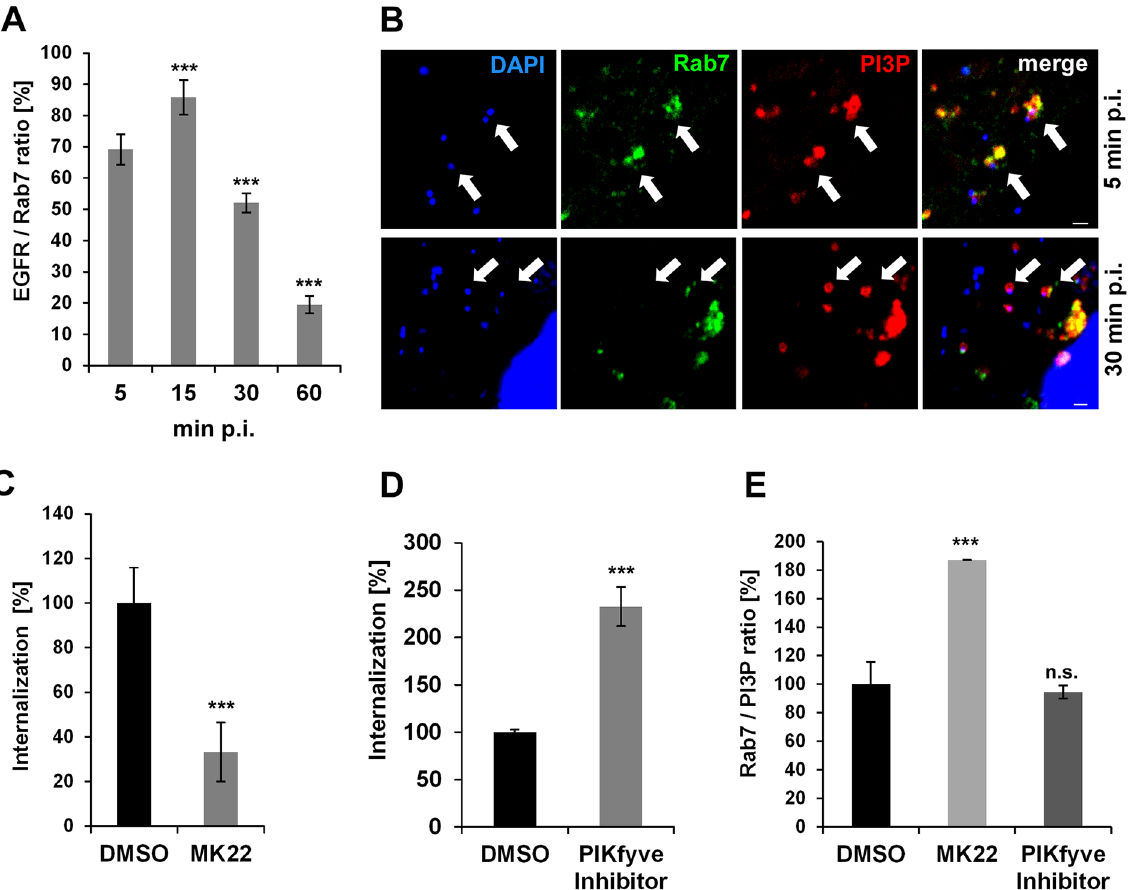
Fig 2. Development of early C . pneumoniae inclusion is dependent on Akt/PIKfyve activity. (A) Quantification of colocalization of Rab7 and EGFR with chlamydialEBs duringthe first hour p.i. in cells transiently transfected with GFP-Rab7 (n = 3). (B) Confocal images of GFP-Rab7 colocalizingwith EBs in PI3P-positiveendosomes (visualizedby mCherry-2xFYVE and DAPI, respectively) at 15 min (top row) and 30 min p.i. (bottom row). White arrows indicatecolocalization. Bar 1 μ m. (C–E) Quantificationof EB internalization in cells pretreated with the indicatedinhibitorfor 2 h prior to infection. Internalization was analyzedin 30 individualcells. (C) Entry of EBs into cells pretreatedwith the Akt inhibitorMK22 (3 μ mol) or DMSO for 2 h prior to infection. Internalization was quantified microscopically at 2 h p.i. (n = 3). (D) Effects of pretreatment with the PIKfyve inhibitor YM201636 (800 nmol) for 2 h prior to infectionon EB internalization(n = 3). (E) Quantification of GFP-Rab7 colocalization with EBs in PI3P-positiveendosomes (visualizedby mCherry-2xFYVE and DAPI) at 30 min p.i. in cells pretreatedwith MK22, the PIKfyve inhibitor or DMSO (n = 3). *** P value (cid:20) 0.001, n.s. P value <